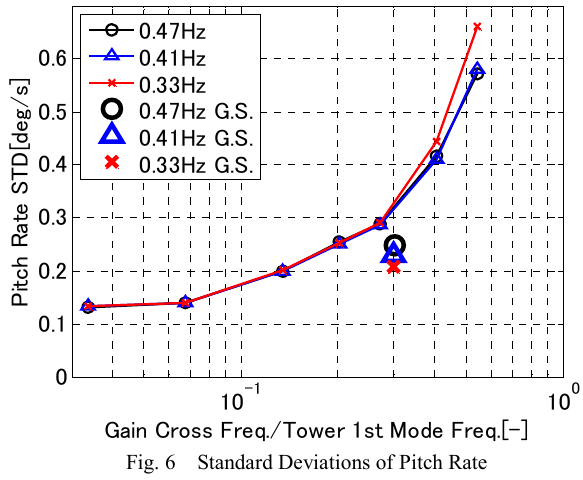
Fig. 6 Standard Deviations of Pitch Rate